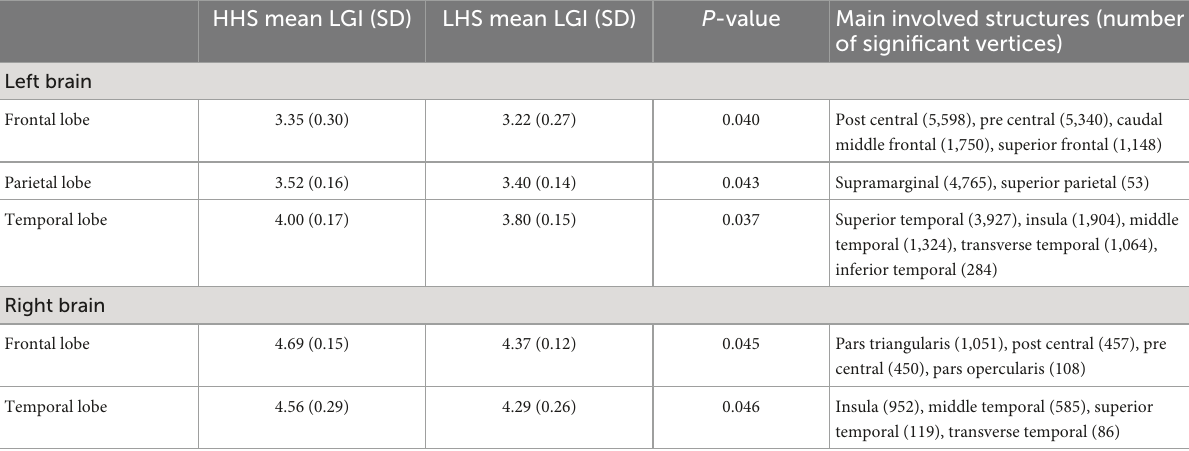
TABLE 4 HHS/LHS direct comparison for mean LGI, between-group differences (uncorrected p ).